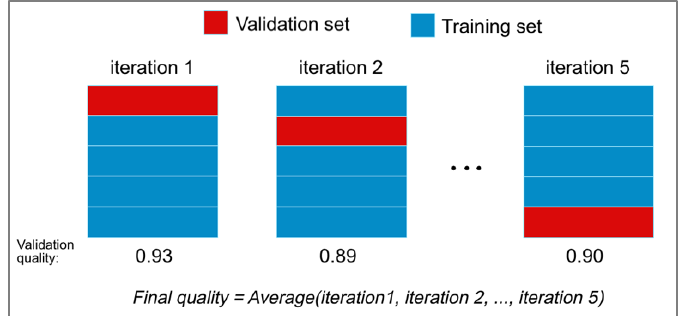
Figure 4. K-fold cross-validation.